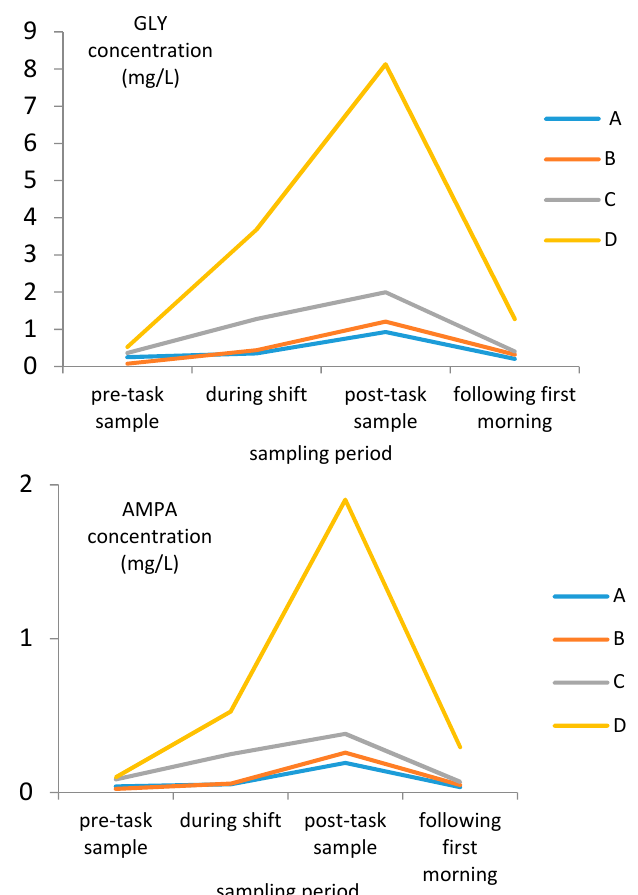
Figure 1. Concentration of GLY and aminomethylphosphonic acid (AMPA) in urine collected in different time periods. (A, B, C and D represents four different sampling objects)